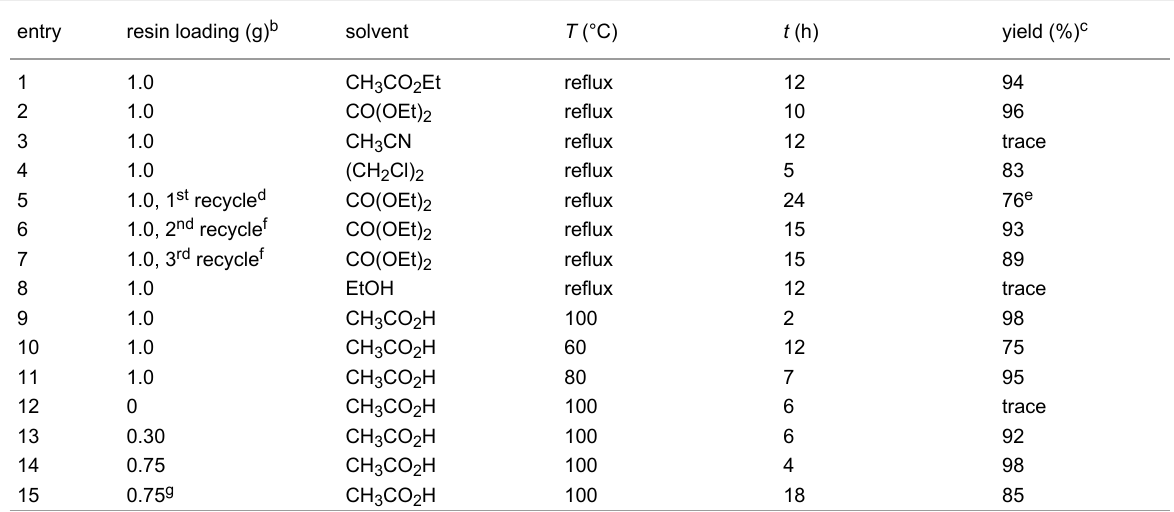
Table 1: Ion-exchange-resin-catalyzed adamantylation of 4-bromophenol ( 1a ) with 1-adamantanol ( 2a ). a